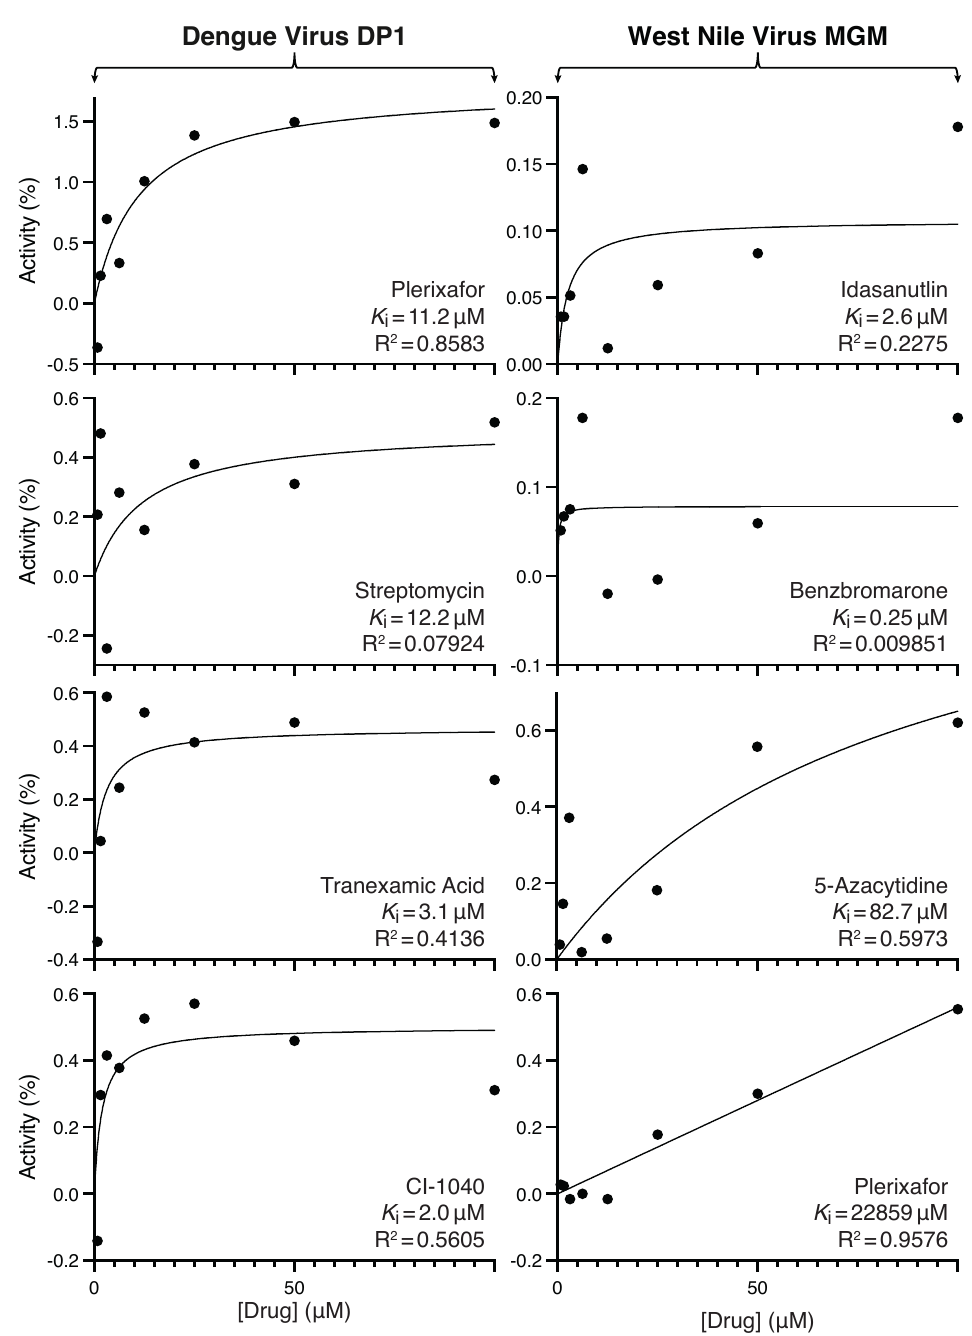
Figure 6. Inhibitory constants of blocker screening results against Dengue Virus DP1 (left column) and West Nile Virus MgM (right column) viroporins using the negative assays (Figure 5a and b). Normalized growth enhancements are depicted as a function of different compound concentrations (0.78–100µM). Bacteria in which the channel expression was not induced or the drug was not added are used as controls. The inhibitory constants are listed in each panel as well as the fitting coefficient.